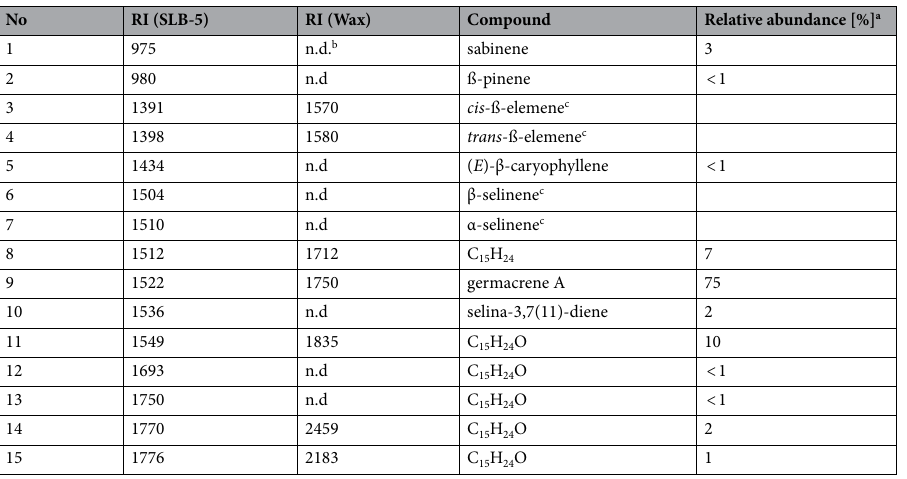
Table 1. Compounds present in the osmeterial secretion of Battus polydamas archidamas . a Due to the